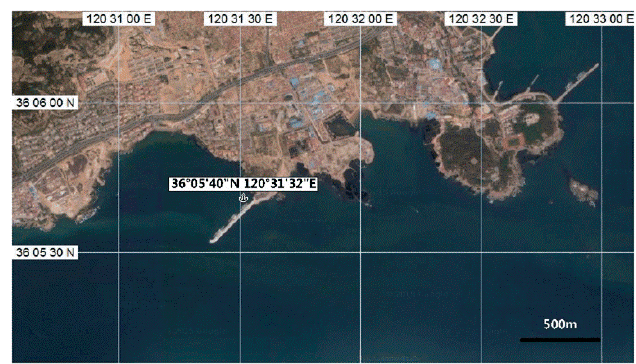
Figure 2. Map showing the location of in situ measurement in the Yellow Sea.